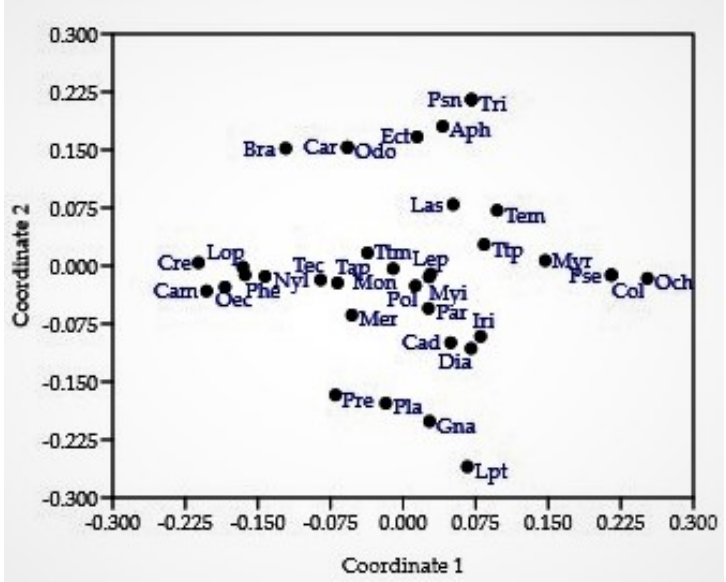
Figure 5. Non-metric dimensional scaling (Bray–Curtis similarity index). Legend genera: Aph :